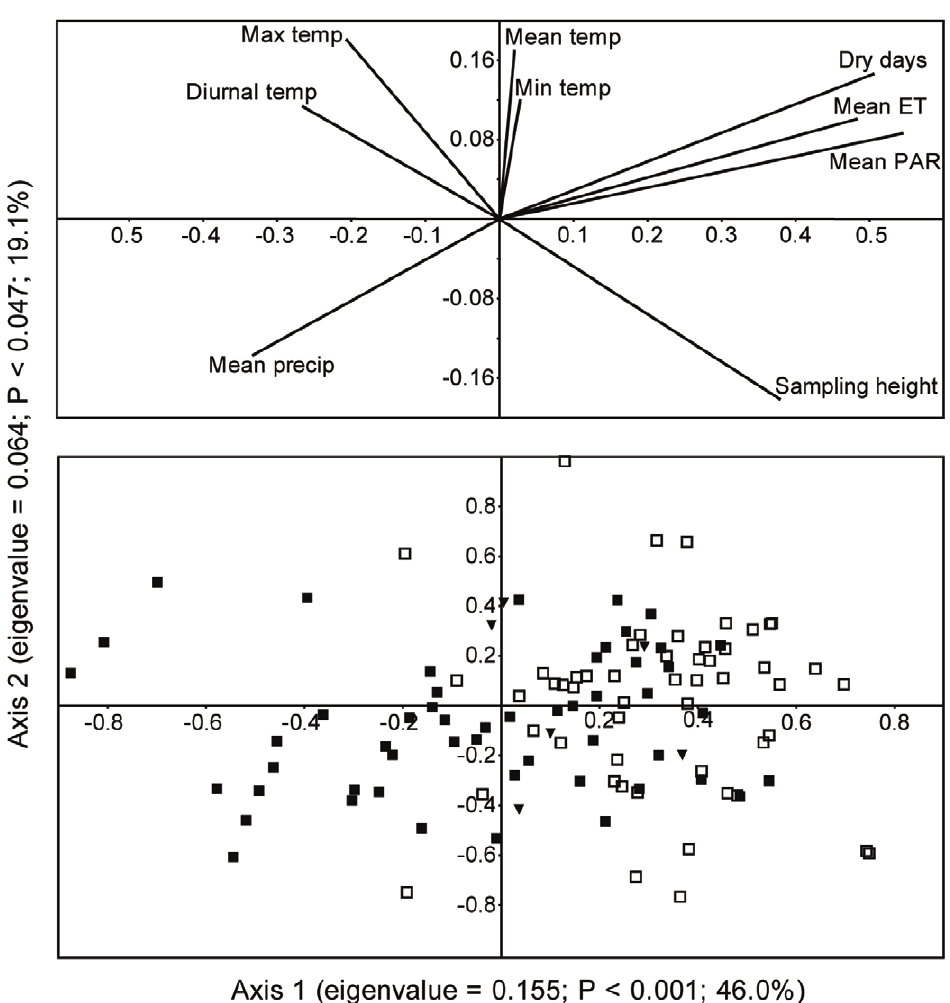
Figure 3. Canonical correspondence analysis of seasonal pollen influx and seasonal climatic conditions. CCA plot of the 111 seasonal pollen assemblages (restricted to the 50 most abundant pollen taxa) and nine environmental variables. The loadings of the nine environmental variables for the first two axes are plotted as vectors (top). Sample loadings for the first two axes are below, with dry season samples depicted as open boxes, wet season samples as filled boxes, and the 1998 samples as filled inverse triangles. Dry and wet season samples ordinate to the right and left, respectively.